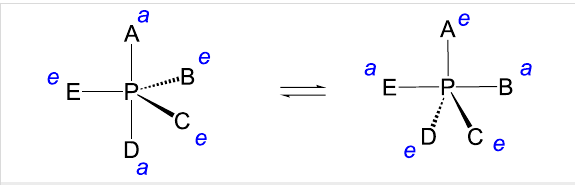
Figure 3: Pseudorotation of a trigonal bipyramidal phosphorane inter- mediate by Berry pseudorotation [20].